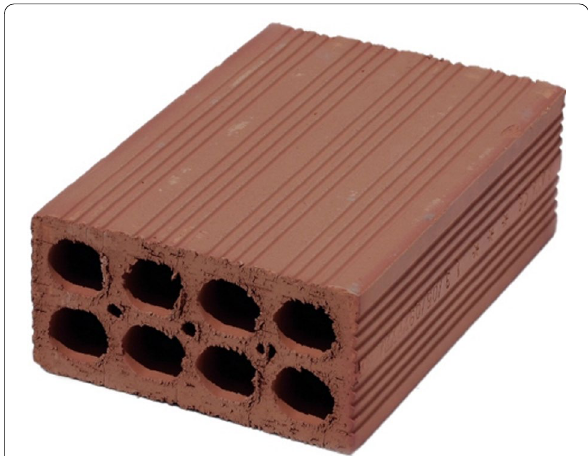
Fig. 3 The hollow brick. Chrysafis Ceramics Ltd. Products-Building Brick CH02. https:// chrys afisb ricks. com/ produ cts/ build ing- brick- ch02